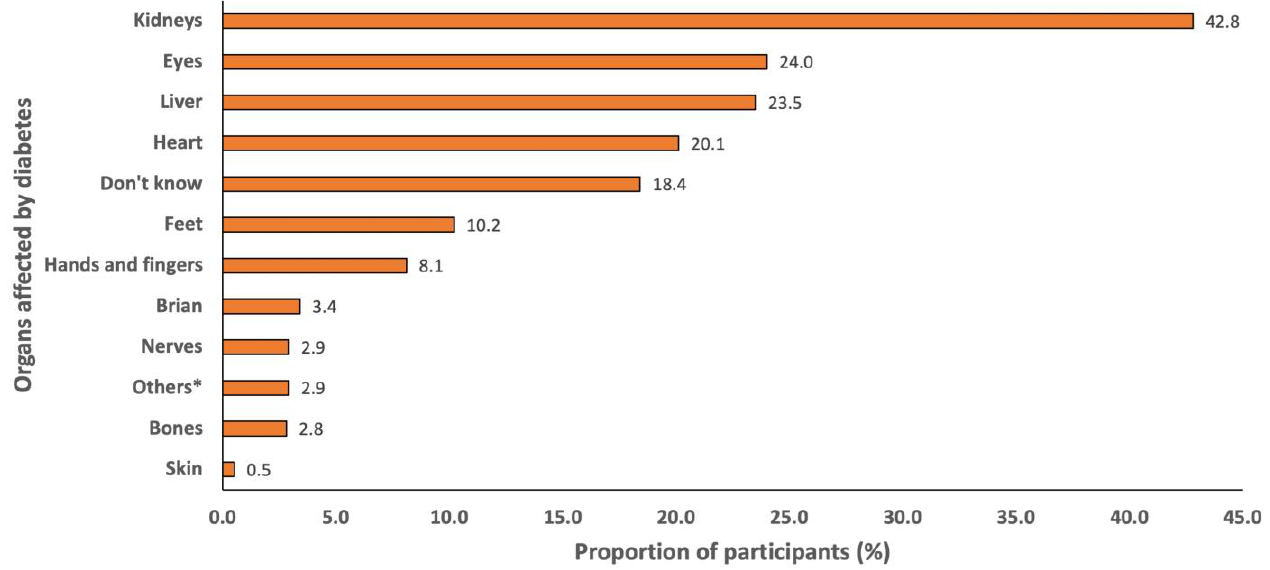
Figure 4. Knowledge of organs affected by type 2 diabetes. * Others include sexual organs, blood vessels, lungs, stomach, intestine, teeth, and intestine.